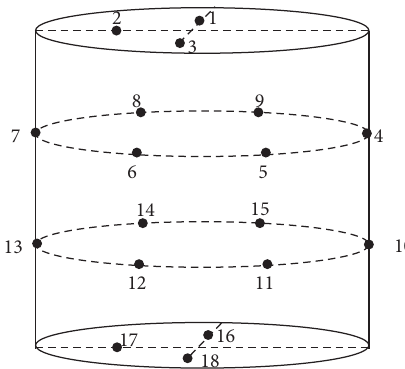
Figure 8: Location distribution of response measuring points.